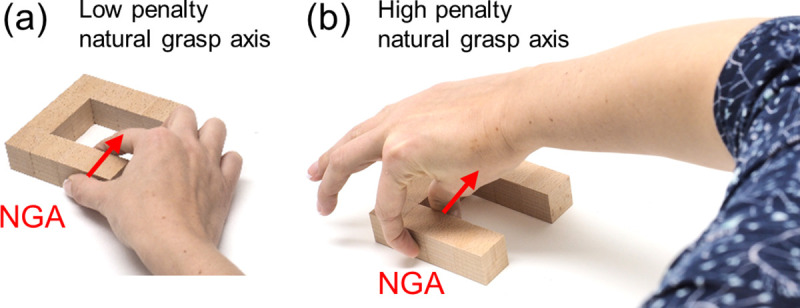
Natural grasp axis.Examples of grasps with (a) low penalty and (b) high penalty grasp axis.